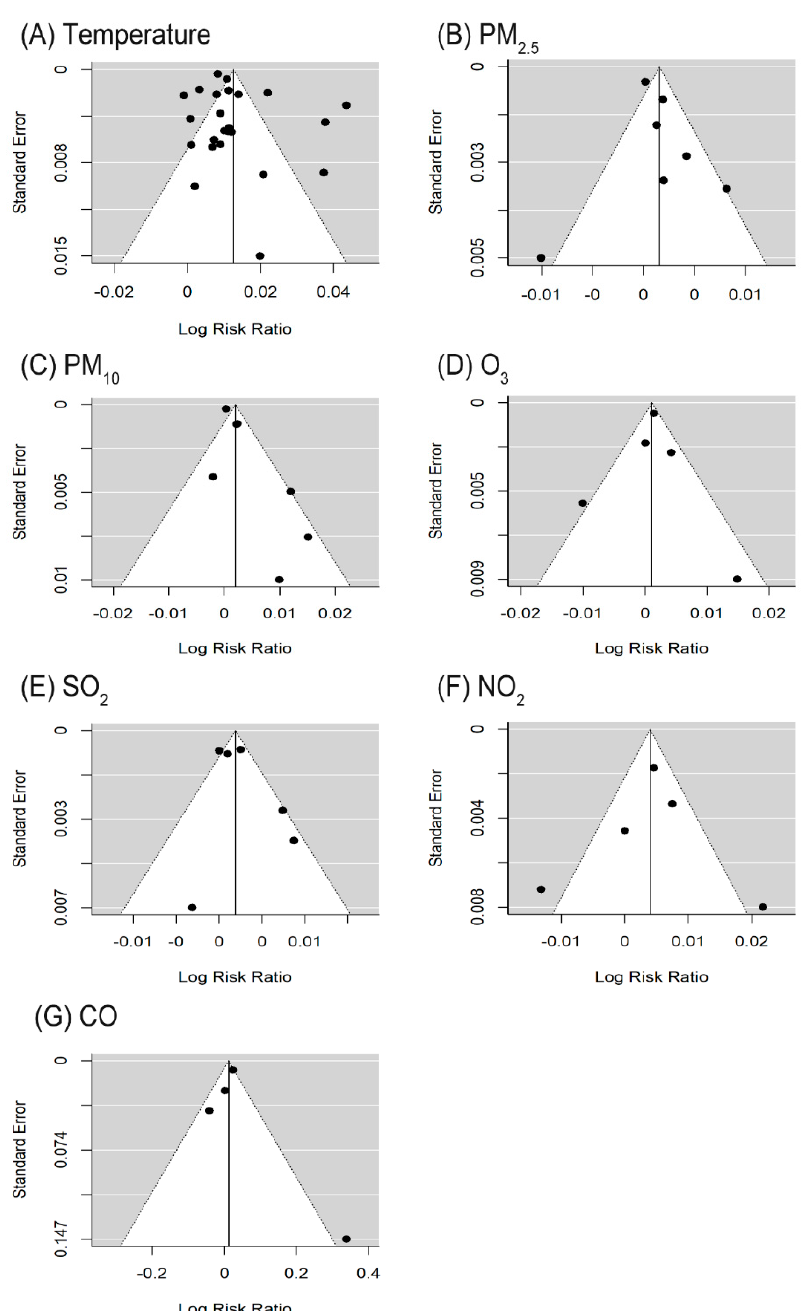
Figure 3. Funnel plots of the meta-analysis for exposure factors (A) Temperature; (B) PM 2.5 ; (C) PM 10 ; (D) O 3 ; (E) SO 2 ; (F) NO 2 ; (G) CO.